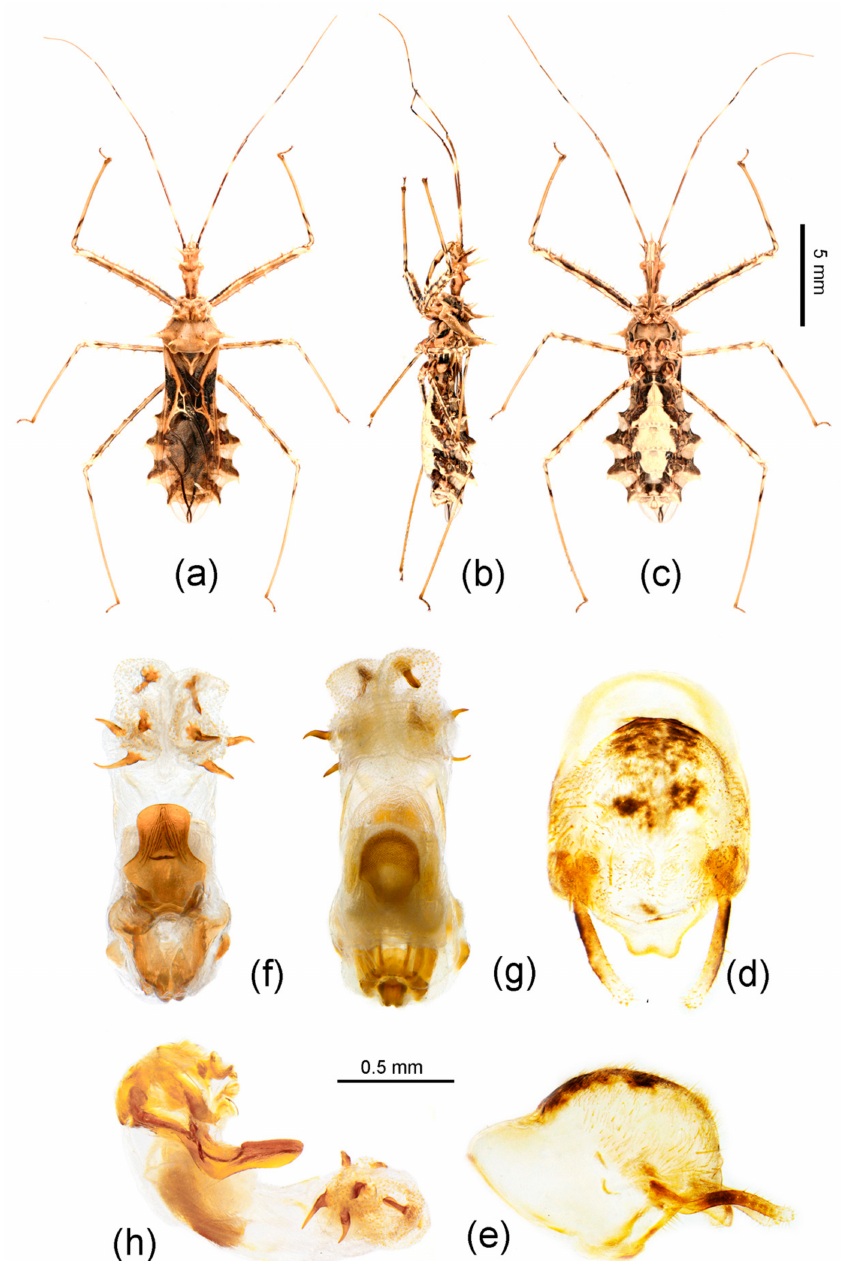
Figure 7. Sclomina erinacea Stål, 1861, ( a – c ) female, GZHP, habitus; ( d – h ) male, GZHP, male external genitalia. ( d , e ) Pygophore with paramere; ( f – h ) phallus. ( a , f ) dorsal view; ( b , e , h ) lateral view; ( c , d , g ) ventral view. Scale bar of ( a – c ) = 5 mm, ( d – h ) = 0.5 mm. Mostly, there are ten spines in the endosoma of the genitalia of Sclomina erinacea (Figure 3i–o; GZLS, GDSG, GXYL, GXJX, GZJP, TWNT, HNBW samples from Central China, and Taiwan and Hainan Islands). However, the endosoma in GZLP and GZHP is armed with eight spines (Figures 3h and 7f–h). The spines of the endosoma are pale and small in several populations from the southeast area of China (Figure 3a–e; JXNC, JXJG, ZJZC, FJQZ, and GDQY samples, including GDMZ). The endosoma of AHFY and CQSMS samples is armed with eleven spines (Figure 3f,g). However, the genetic distance between individuals and populations of Sclomina erinacea was not significant compared to the five delimited species (Tables S3 and S4). The population change of this species deserves further